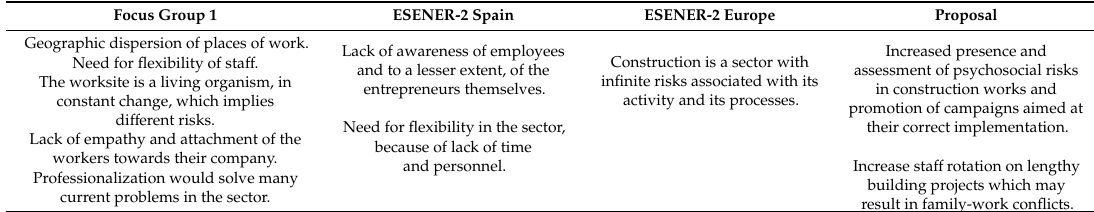
Table 6. Conclusions drawn from focus group 1 and the Second European Survey of Enterprises on New and Emerging Risks (ESENER-2, in both its European and Spanish versions), referring to the third indicator (barriers to entering due to the singularities of the construction sector) used as a guide in the discussion groups. Source: [61,62]. Focus Group 1 ESENER-2 Spain ESENER-2 Europe